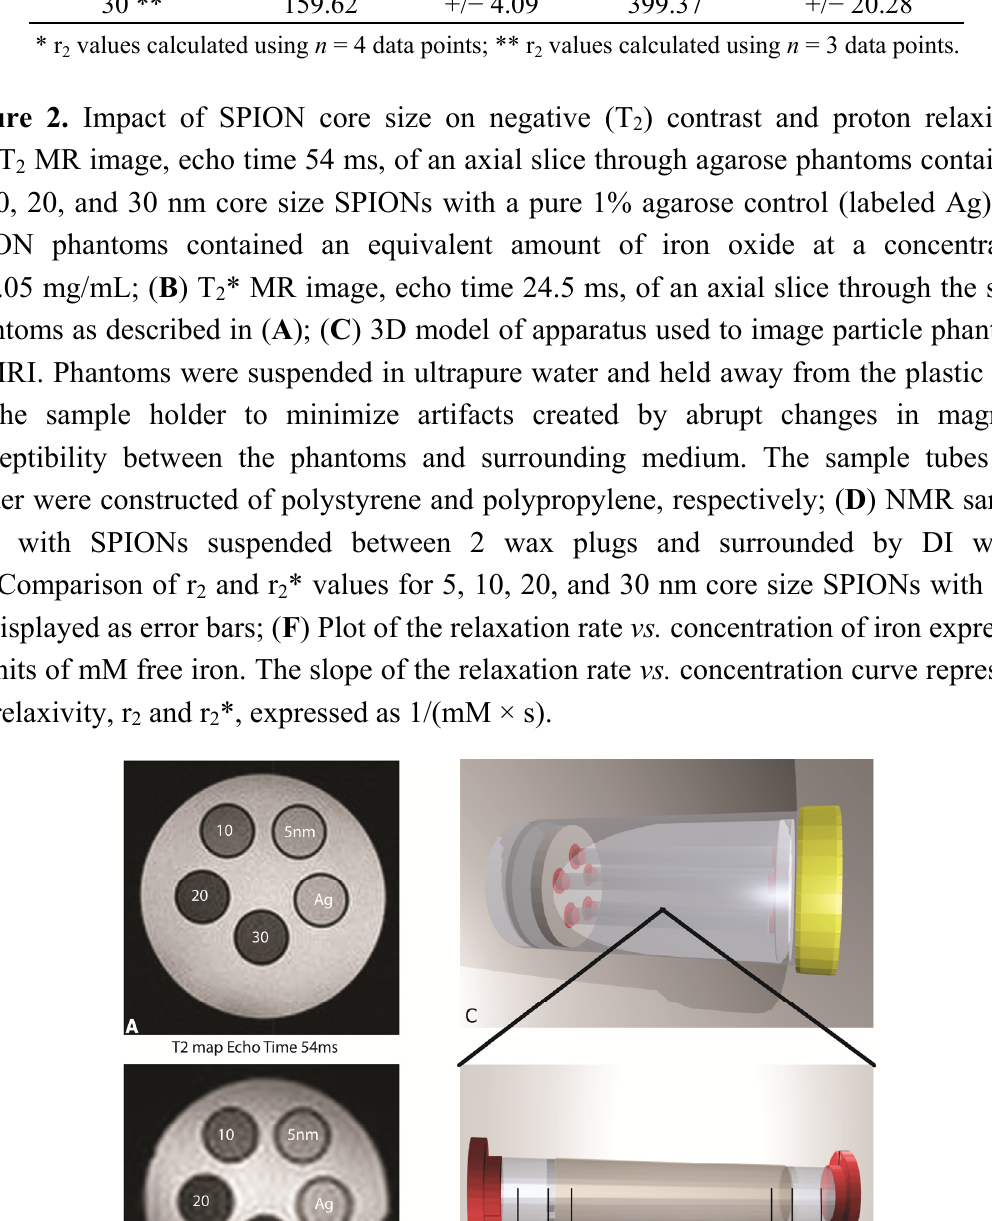
Table 1. Relaxivity values r points except as indicated).